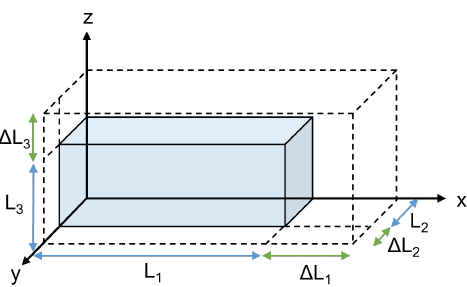
Figure 4. Schematic of material deformation. The variables L 1 , L 2 , and L 3 correspond to the initial length in the x -, y -, and z -direction, respectively. ∆ L 1 , ∆ L 2 , and ∆ L 3 correspond to the change in length in the x -, y -, and z -direction, respectively, resulting from the material deformation due to a temperature